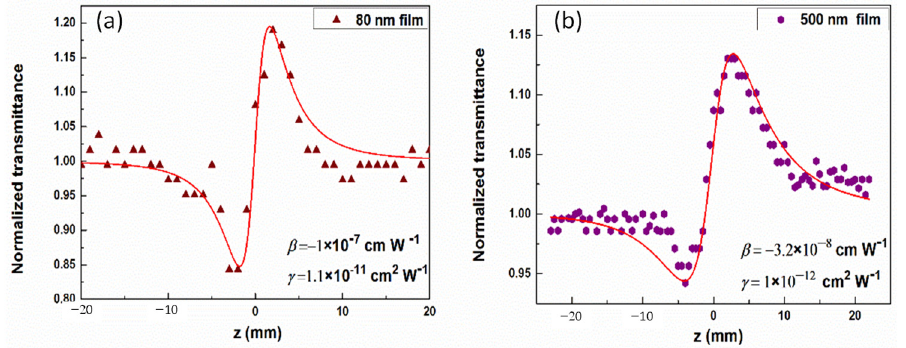
Figure 3. Z-scan measurements of Ag 2 S QD films at λ = 800 nm. CA Z-scans of ( a ) 80 nm and ( b ) 500 nm thick films. Solid curves show the fits of Z-scans. Reprinted with permission from Ref. [25], 2019, Walter de Gruyter GmbH & Science Wise Publishing.